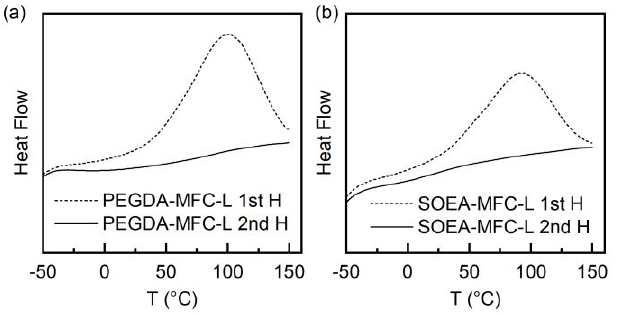
Figure 6. DSC thermograms of the 1 st and 2 nd heating cycles for ( a ) PEGDA-MFC-L and ( b ) SOEA- MFC-L. ( b )